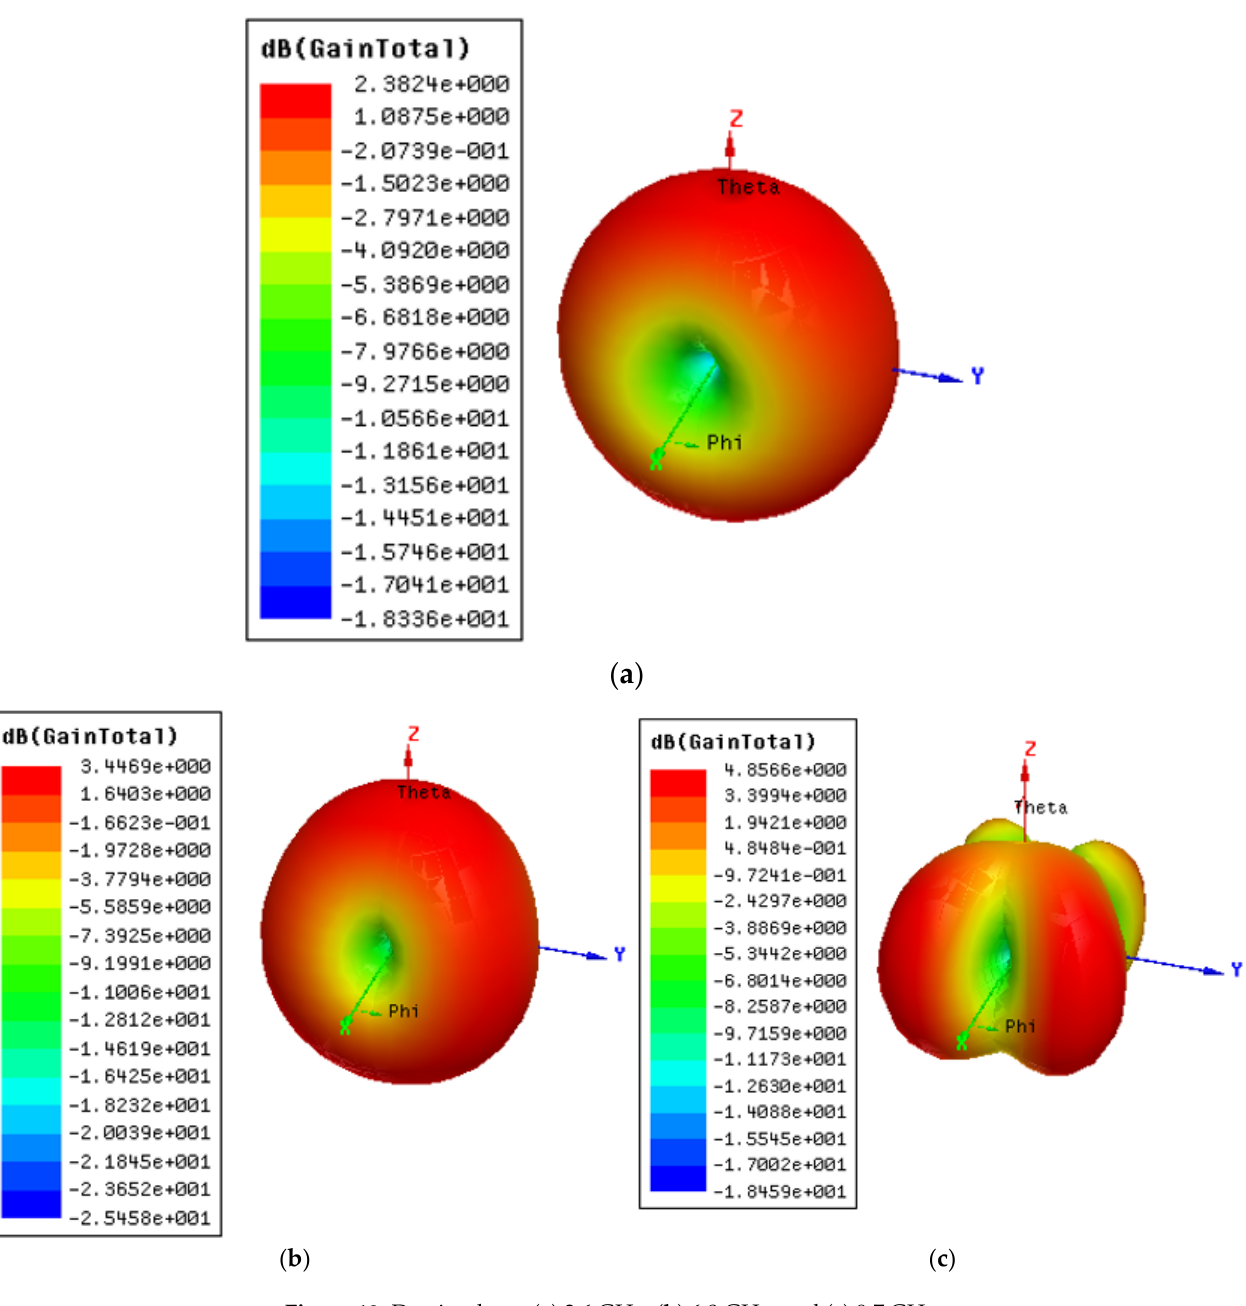
Figure 18. D gain plot at ( a ) 3.6 GHz, ( b ) 6.8 GHz, and ( c ) 9.7 GHz. Figure 19 shows that a maximum gain of 4.9 dB is achieved for the UWB microstrip antenna.